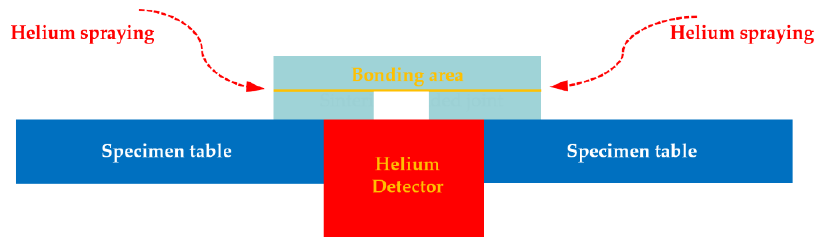
Figure 11. Schematic representation of gas tightness test for sintering bonded joint.